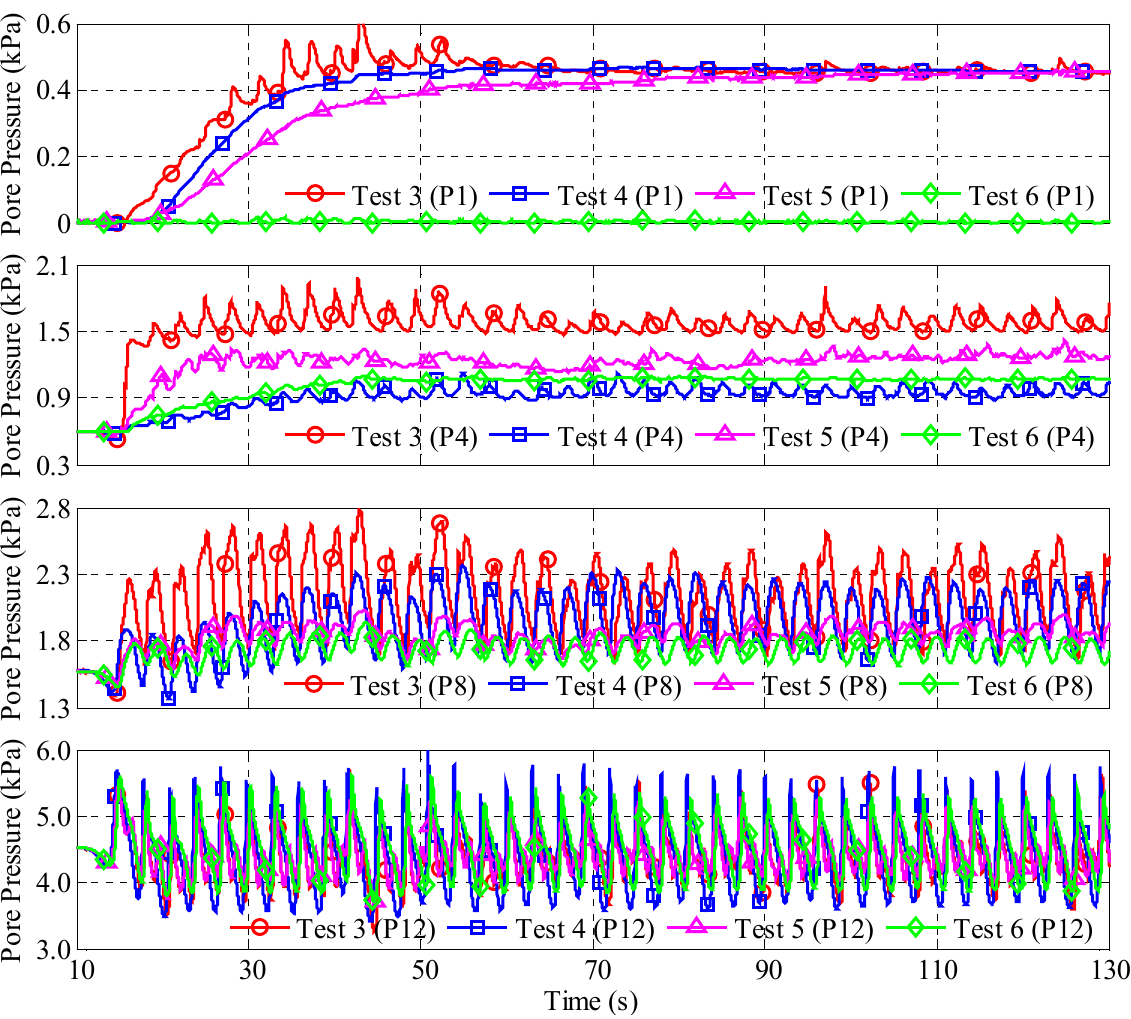
Figure 22. Comparison of the pore pressure recorded at P1, P4, P8 and P12 among Test 3 (no armor block), Test 4 (accropodes), Test 5 (rubble) and Test 6 (accropodes and rubble).